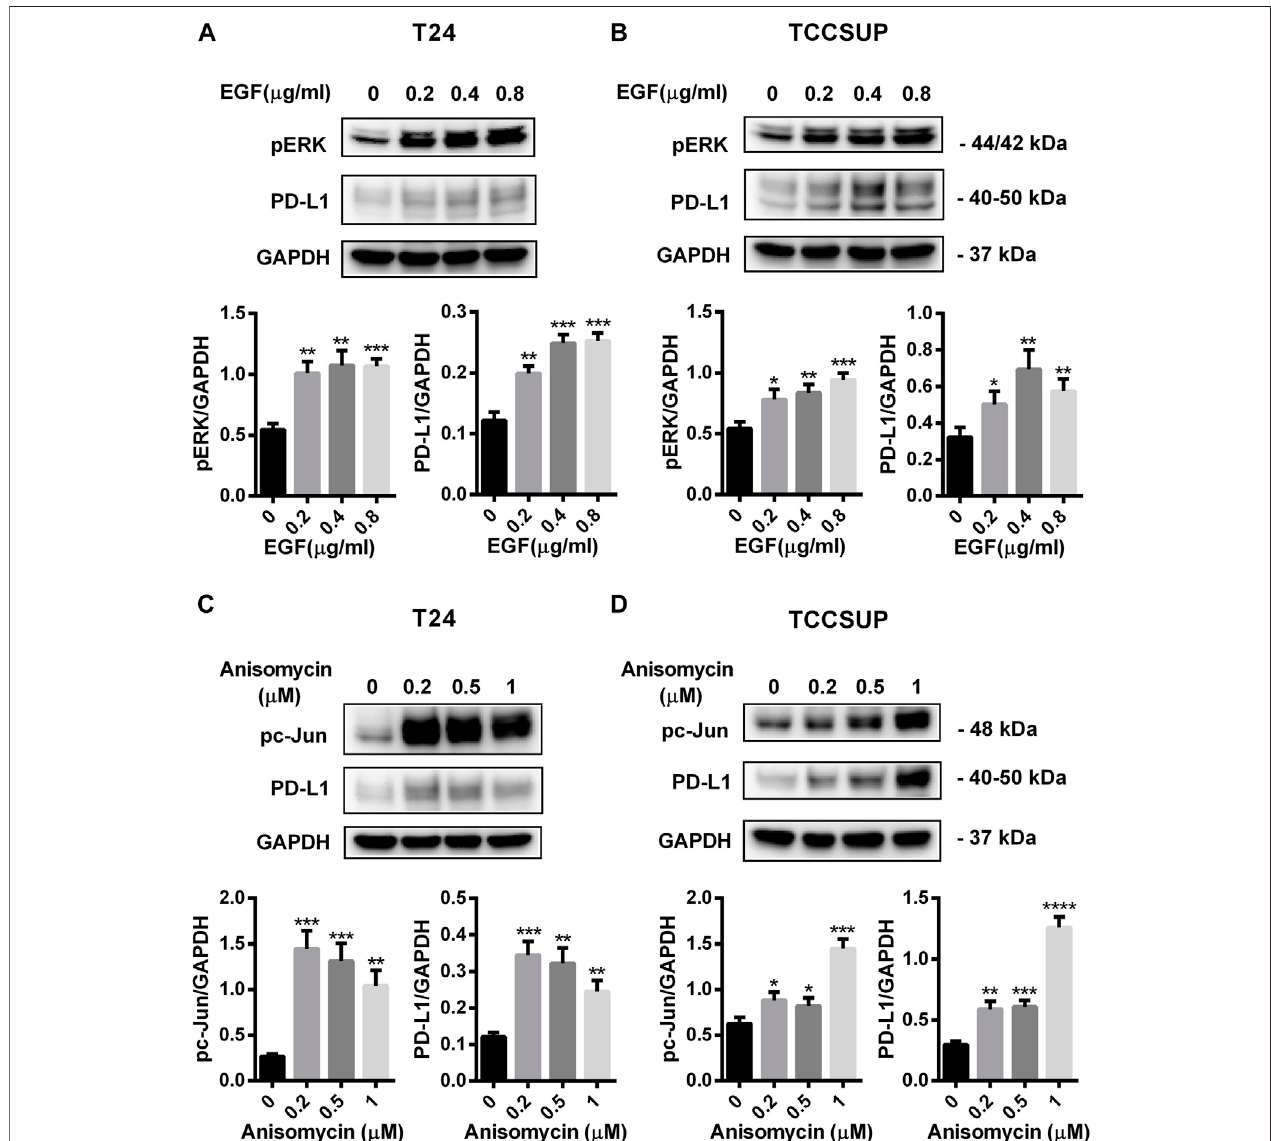
FIGURE 6 | PD-L1 expression was upregulated by EGF and Anisomycin in T24 and TCCSUP cells. (A,B) The protein levels of pERK and PD-L1 in T24 and TCCSUPcellsafterculturingwithdifferentconcentrationsofEGF(aligandofEGFR,oftenusedtoactivateERKsignal,0,0.2,0.4and0.8 μ g/ml)for2 h (C,D) Theprotein levels of pc-Jun and PD-L1 in T24 and TCCSUP cells after culturing with different concentrations of Anisomycin (a JNK activator, which can activate c-Jun, 0, 0.2, 0.5 and1 μ M)for24 h.ThedensitometricanalysisofproteinswasperformedandtheresultswerenormalizedtoGAPDH.Theresultswereconsideredsigni fi cantat p < 0.05 (* p < 0.05, ** p < 0.01, *** p < 0.001, **** p <